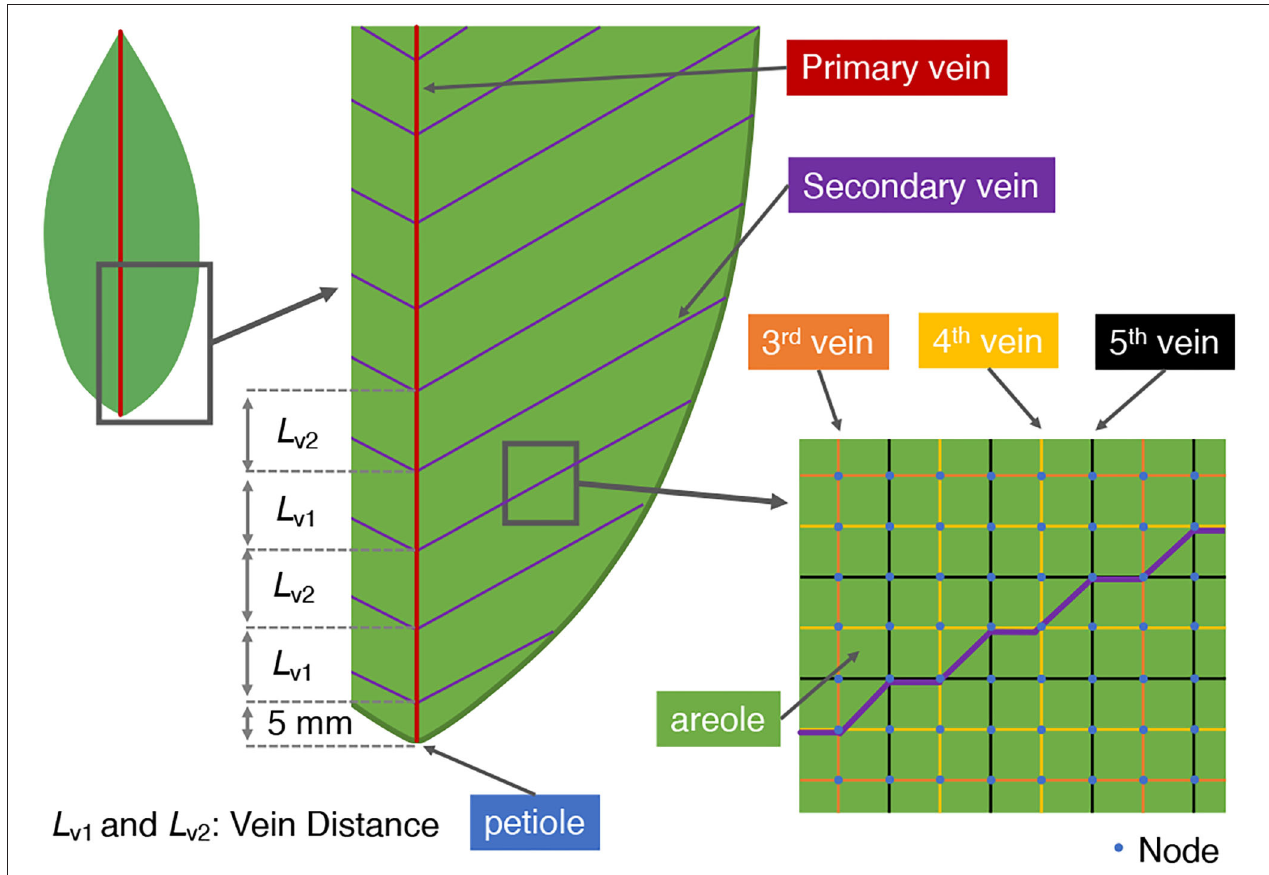
FIGURE 2 | Vein architecture of the model leaf. In our simulations, the angle of the second-order vein to the main vein is varied. Accordingly, the vein distances L v 1 and L v 2 are also varied (alternately) to ensure a constant total vein